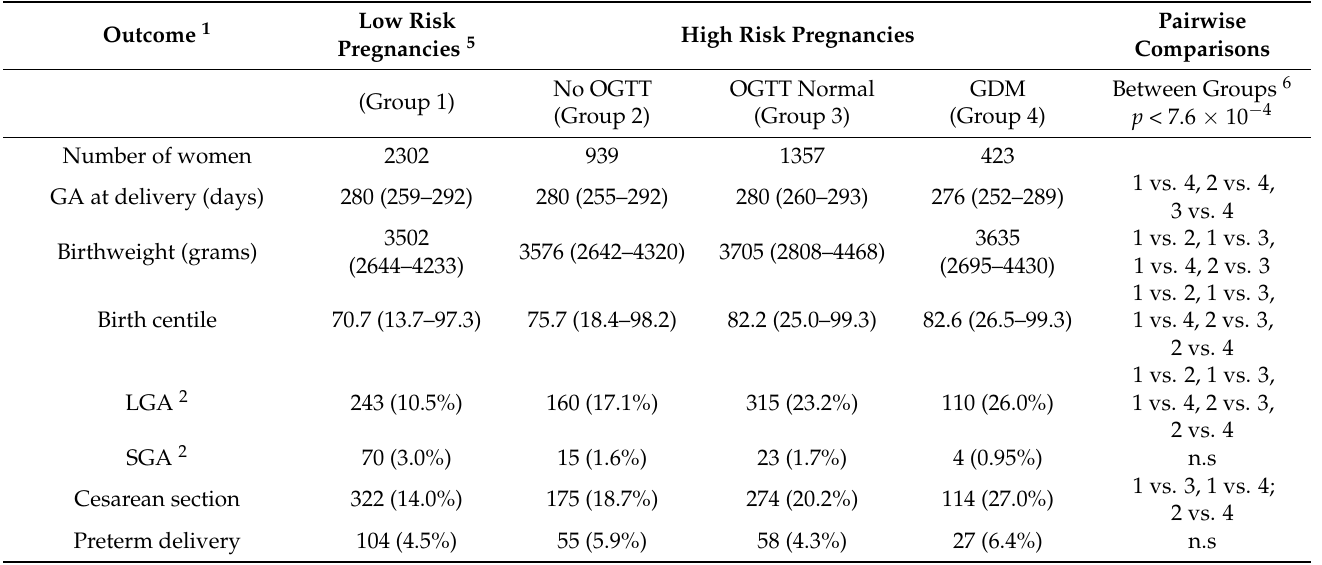
Table 3. Pregnancy outcome in women allocated into four subgroups according to GDM risk factors and OGTT